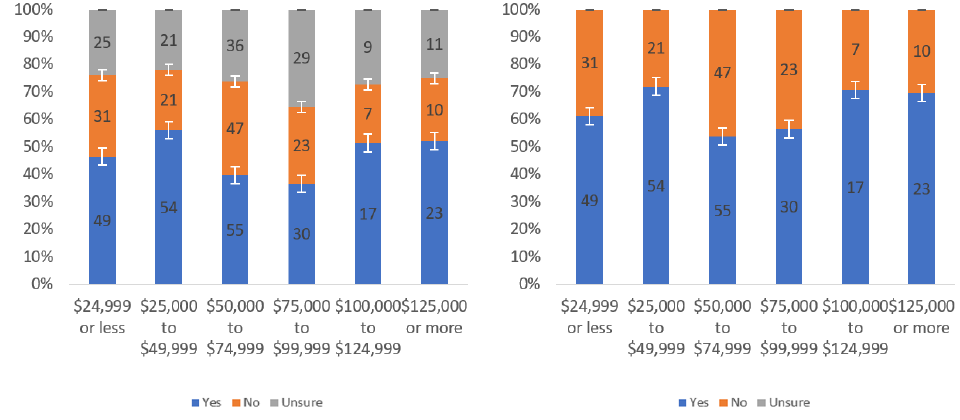
Figure 64. Responses regarding others’ willingness to review by income level including ( left ) and excluding ( right ) unsure responses.